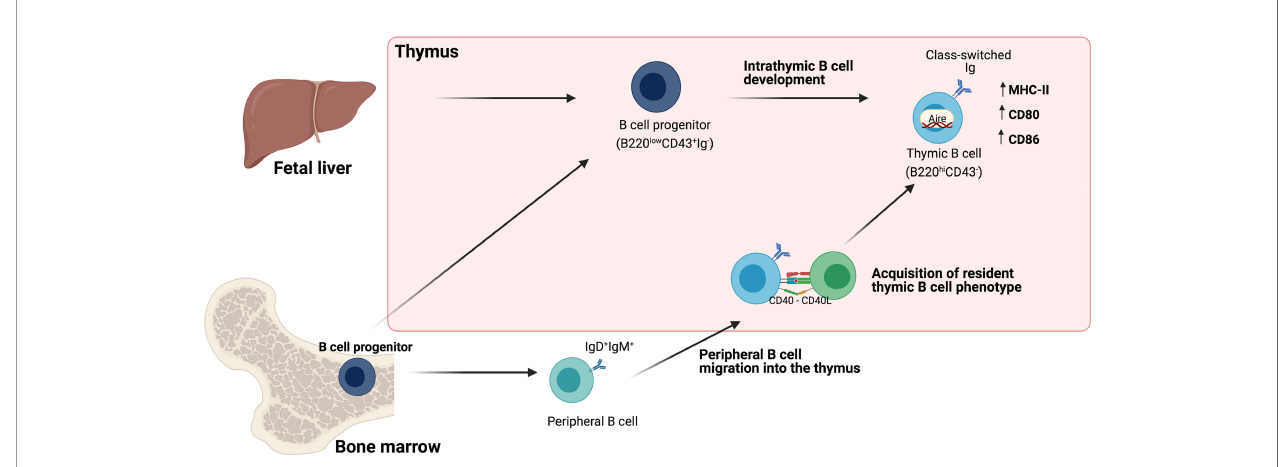
FIGURE 1 | Origin of Thymic B cells. Schematic representation of different pathways involved in the origin of thymic B cells. One pathway proposes intrathymic differentiation from fetal liver and bone marrow B cell progenitors that give rise to resident thymic B cells. A second pathway is the migration of mature B cells, which acquire the phenotype of resident thymic B cells through the interaction with developing thymocytes (discussed in Section